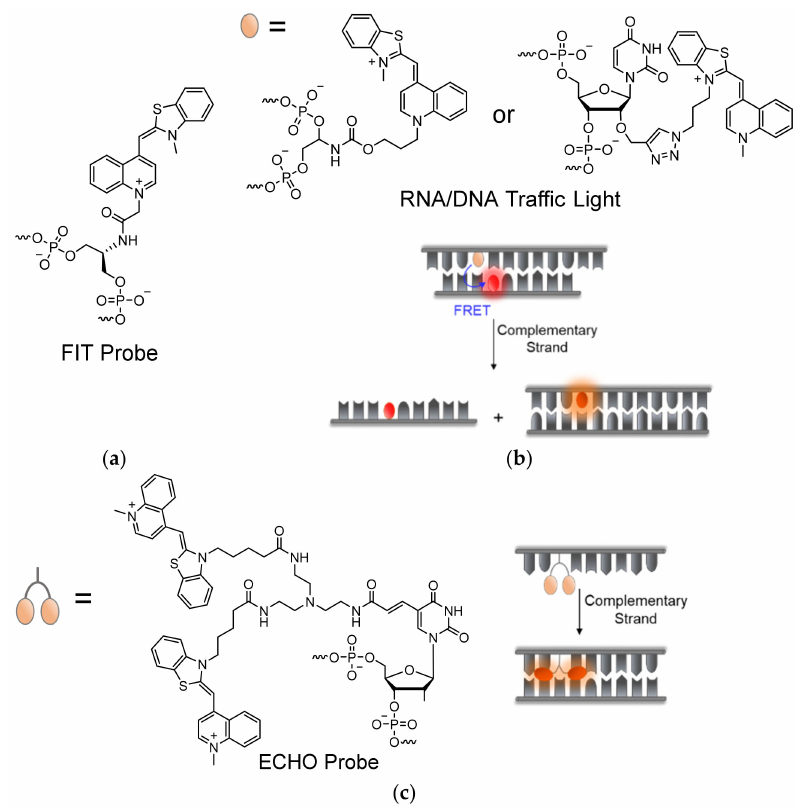
Figure 6. DNA-based TO probes. Presented are the chemical structures and the operating mecha- nisms of ( a ) DNA-based FIT-probes (refer to Figure 4a for the mechanism); ( b ) DNA/RNA traffic lights; ( c ) ECHO